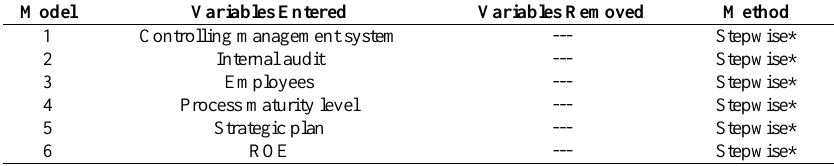
Table 1. Dependent Variable Innovation plan, variables Entered/Removed Model